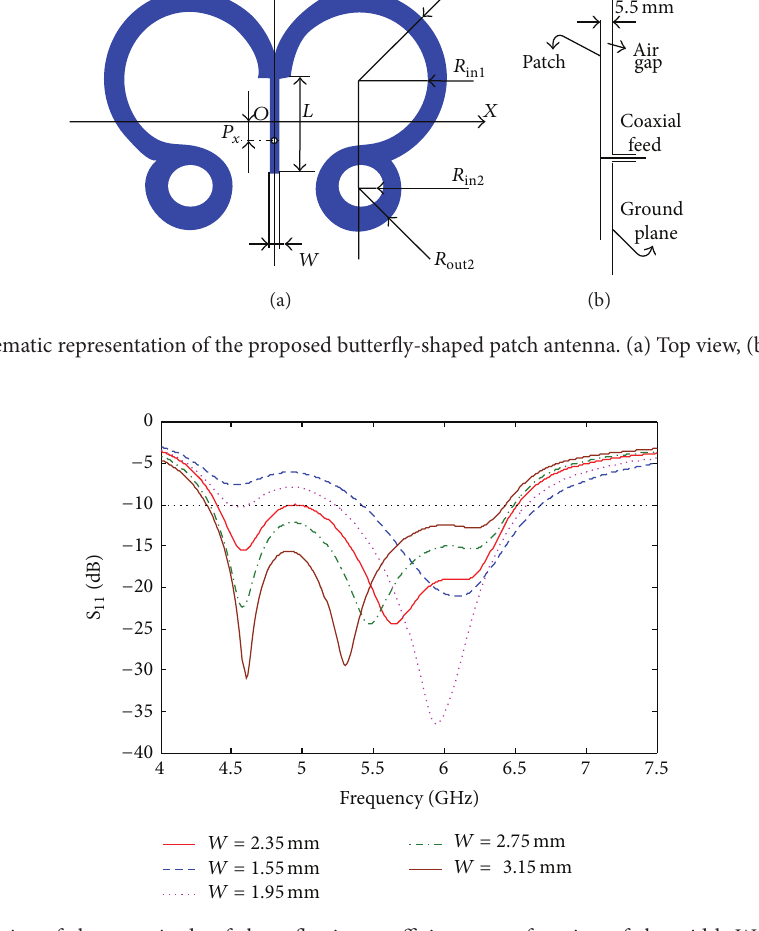
Figure 2: Frequency behavior of the magnitude of the reflection coefficients as a function of the width 𝑊 with 𝐿 = 21.79 mm, 𝑃 𝑥 = = 15.29 mm, 𝑅 = 20.22 mm, 𝑅 = 8.70 mm, and 𝑅 = 10.09mm. 3.85 mm, 𝑅 in 1 out 1 in 2 out 2